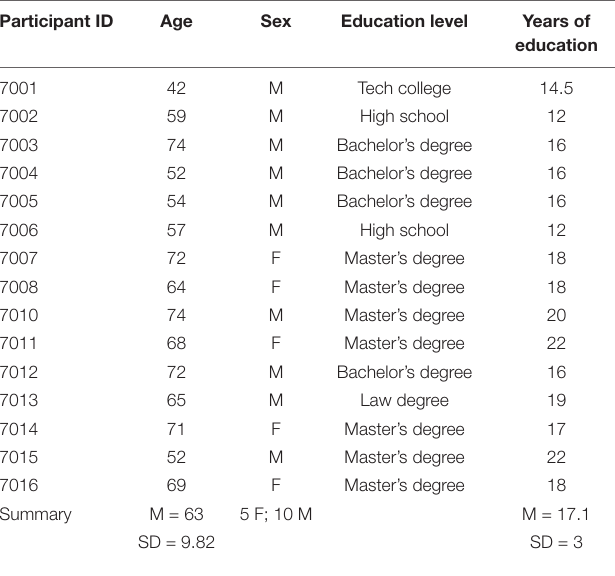
TABLE 2 | Demographic characteristics of age-matched control